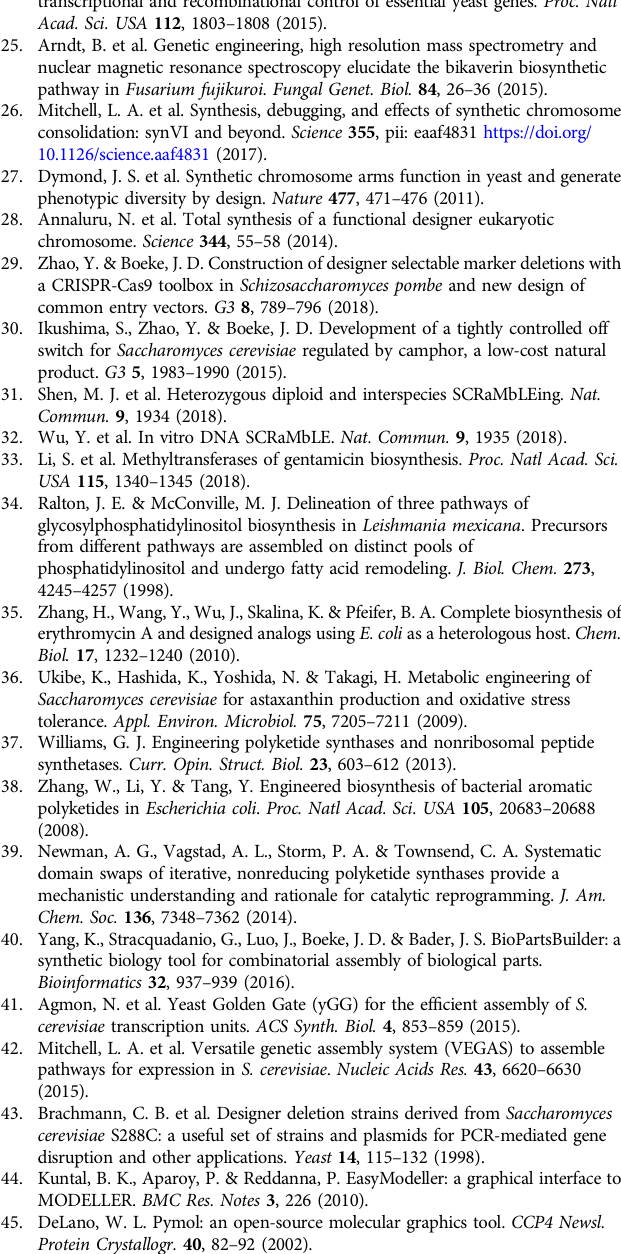
a Supplementary Information fi le. The datasets and materials generated and analyzed during the current study are available from the corresponding author upon request. The protein sequences of Bik1, Bik2, Bik3, Bik6, Ppt1, and NpgA were obtained from the NCBI Protein database (accession numbers: Bik1, S0DZM7; Bik2, S0E2X6; Bik3, S0E608; Bik6, S0DZN4; Ppt1, CCE73639; NpgA, AAF12814). Their DNA sequences used in this study were provided in Supplementary Data 1. The templates of Bik2 and Bik3 used for homology modeling were obtained from RCBS-PDB database (PDB ID: 5KOW and 5W7P-A, respectively). The LC – MS spectra data are available in Supplementary Figs. 4 – 8. Source data are provided with this